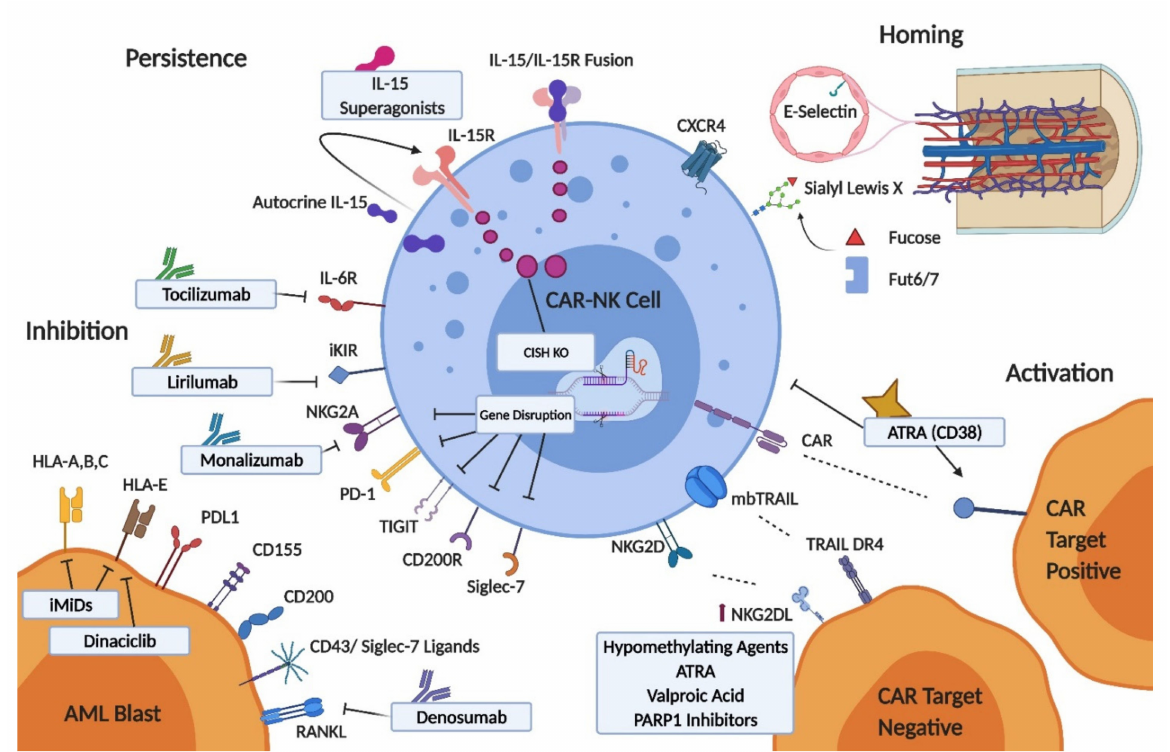
Figure 3. Pathways to augmenting CAR-NK in AML. RANK = receptor activator of nuclear factor kappa-B; TIGIT = T-cell immunoglobulin and immunoreceptor tyrosine-based inhibitory motif (ITIM) domain; PD-1 = programmed cell death protein 1; iKIR = inhibitory killer immunoglobulin receptor; PD-L1 = programmed death-ligand 1; RANKL = receptor activator of nuclear factor kappa-B ligand; iMiDs = immunomodulatory drugs; FUT6/7 = alpha-1,3-fucosyltransferases 6 and 7; ATRA = all-trans retinoic acid; PARP1 = Poly (ADP-ribose) polymerase 1; CISH = cytokine-inducible sh2-containing protein; CAR = chimeric antigen